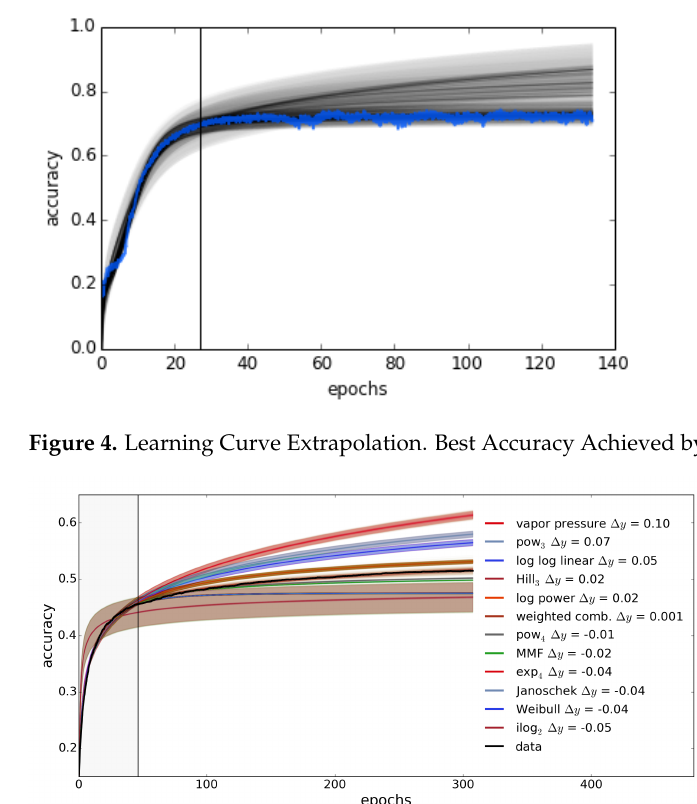
Figure 5. Comparison of an observed learning curve (black) with 11 types of learning curve models and a linear combination of them. Each type is parameterized to fit the first 50 observations y 1:50